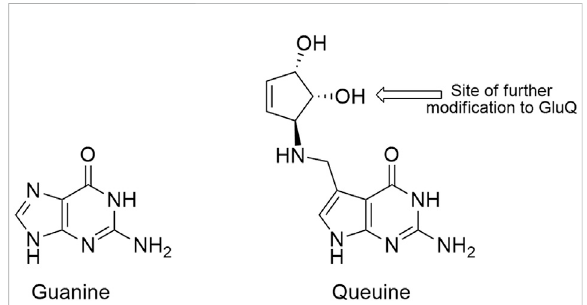
FIGURE 1 Structures of guanine (G, left) and the modi fi ed guanine, queuine (Q, right). The arrow on queuine indicates the position of glutamic acid esteri fi cation, a further modi fi cation found in the E. coli aspartic acid